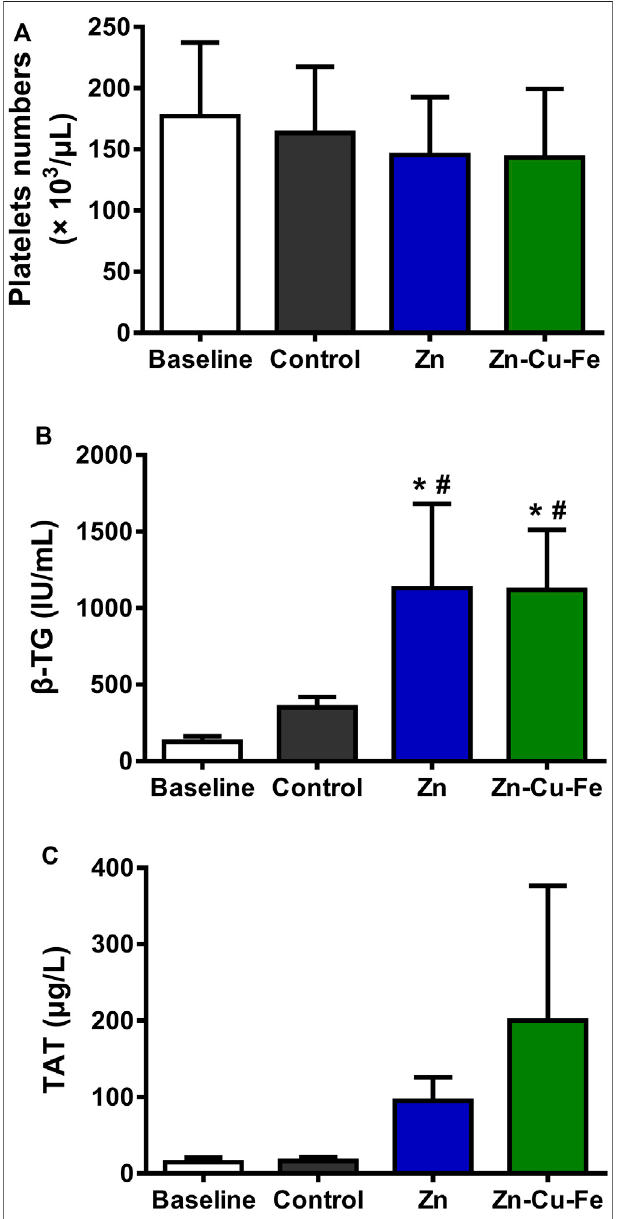
FIGURE 8 | The number of platelets and plasma markers after 60 min of exposure to blood using the Chandler-Loop model: (A) the number of platelets (10 3 / μ L), (B) β -thromboglobulin release (IU/ml), and (C) thrombin- antithrombin III level (ug/L). * and # indicate p < 0.05 based on one-way ANOVA followed by post hoc Tukey ’ s test, compared to the baseline and controls, respectively. After 60 min of circulation, platelets and the related plasma markers were analyzed. Although the number of platelets exposed to Zn and Zn-Cu-Fe had slightly decreased, no signi fi cant differences could be observed between different groups (F (3, 12) = 0.347, p = 0.791), as shown in Figure 8A . However, the concentration of β -TG was regarded as an ef fi cient marker of